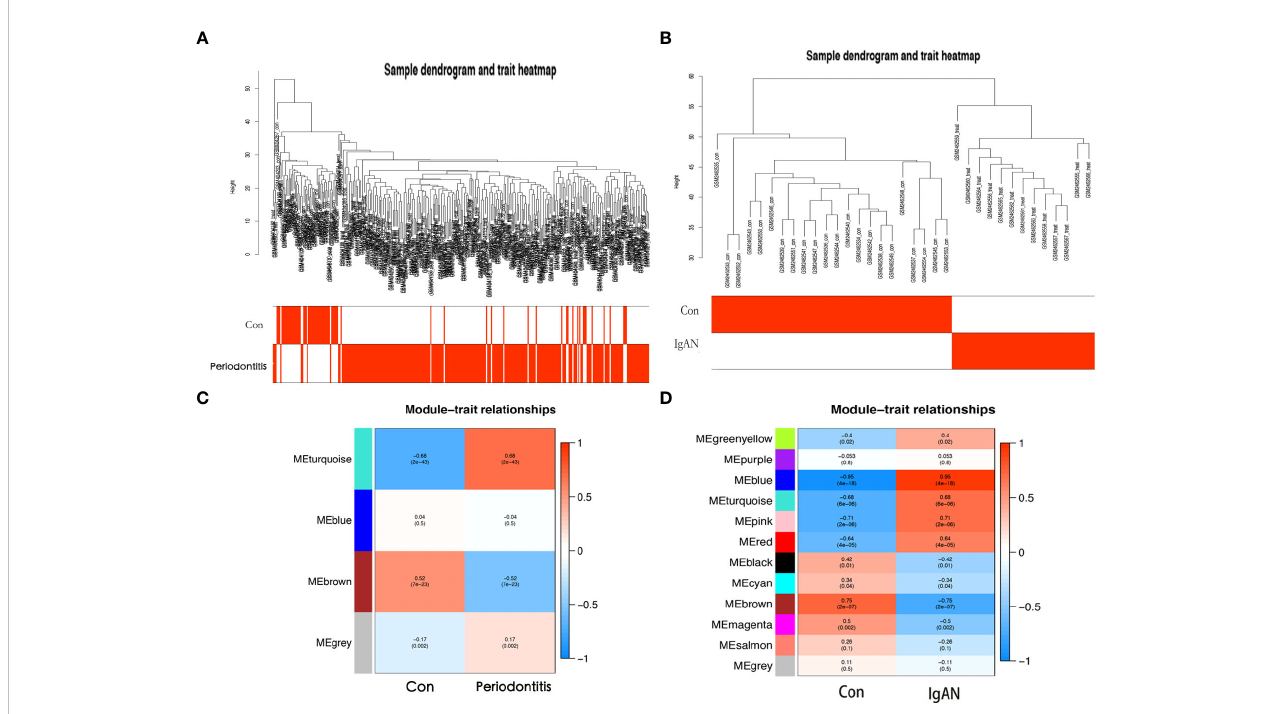
FIGURE 3 Coexpression analysis for differentially expressed genes. (A) Sample dendrogram and trait heatmap in GSE16134. (B) Sample dendrogram and trait heatmap in GSE93798. (C) Heatmap of the module-trait relationships in GSE16134. (D) Heatmap of the module-trait relationships in GSE16134. Con: control; IgAN: IgA